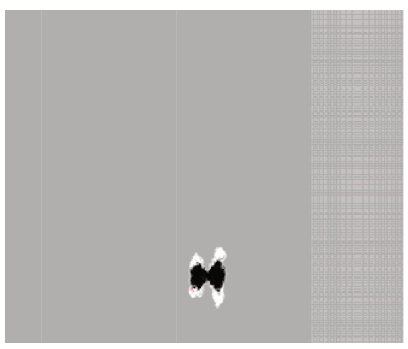
Figure 3: 100-mm borehole acoustic emission damage cloud map.